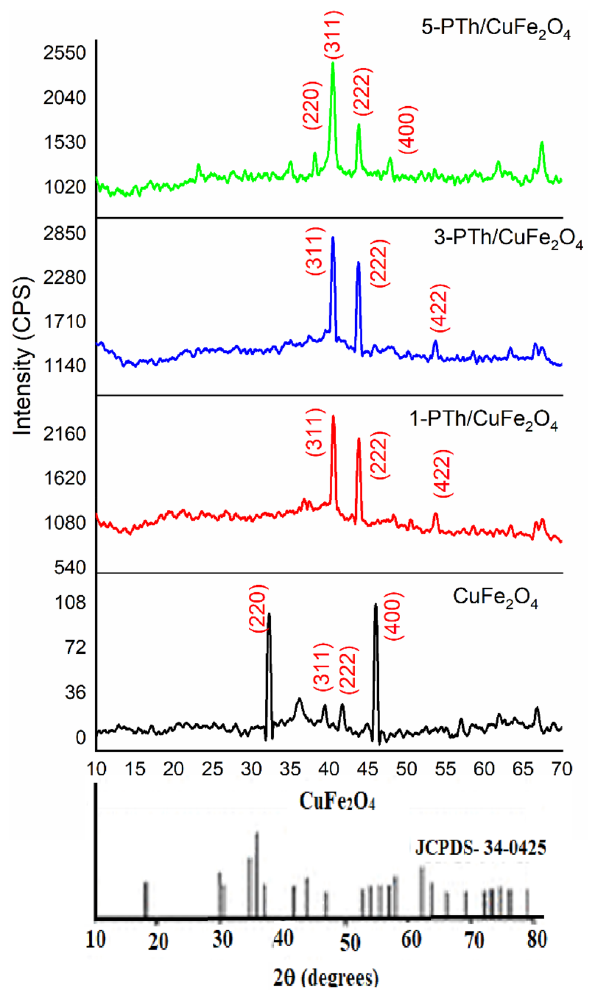
Figure 1. XRD profile of CuFe 2 O 4 , 1-PTh/CuFe 2 O 4 , 3-PTh/CuFe 2 O 4 , and 5-PTh/CuFe 2 O 4